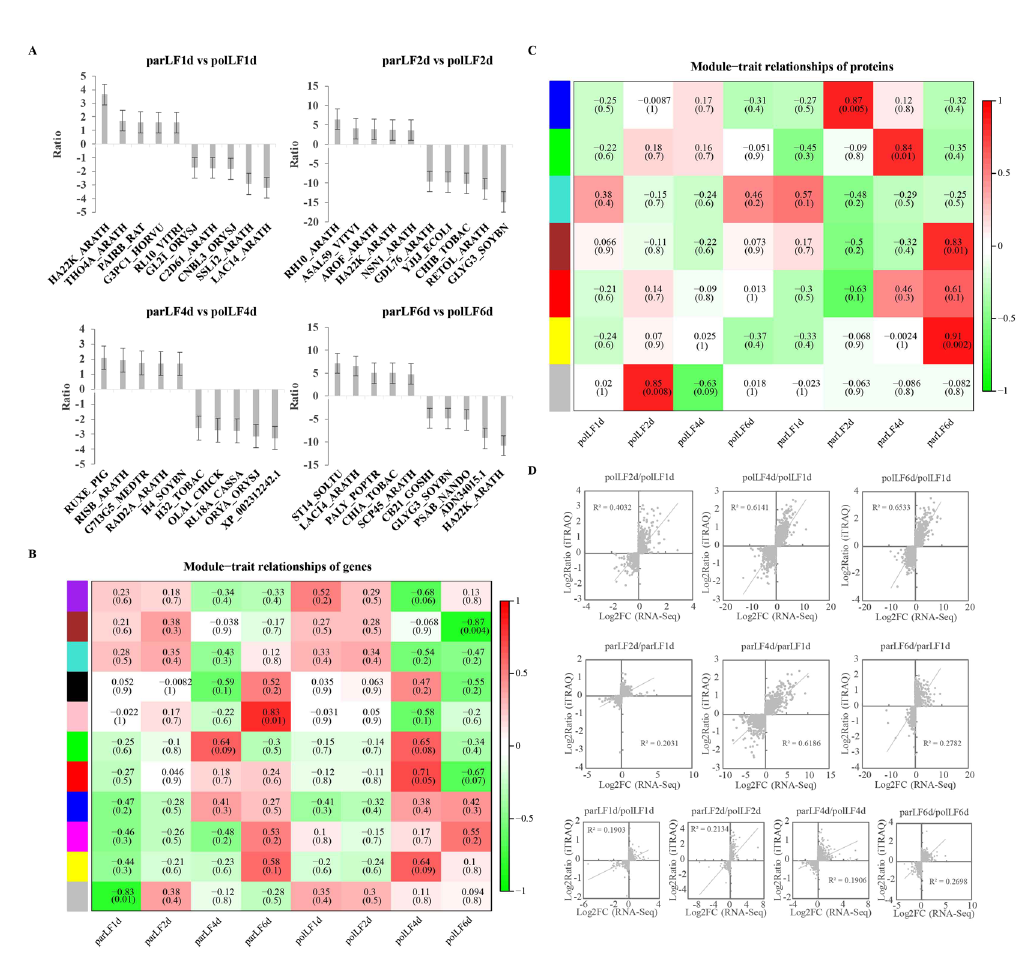
Figure 5. Comparison of DEGs and DEPs identified in this study. ( A ) Top 5 up-/down-regulated proteins in parLFs compared to polLFs at different time stages. Error bars stand for the standard division. ( B ) Module- trait relationships of co-expressed genes in polLFs and parLFs. ( C ) Module-trait relationships of co-expressed proteins in polLFs and parLFs. ( D ) Scatter plots of DEGs/DEPs in polLFs and parLFs identified transcriptome sequencing and iTRAQ